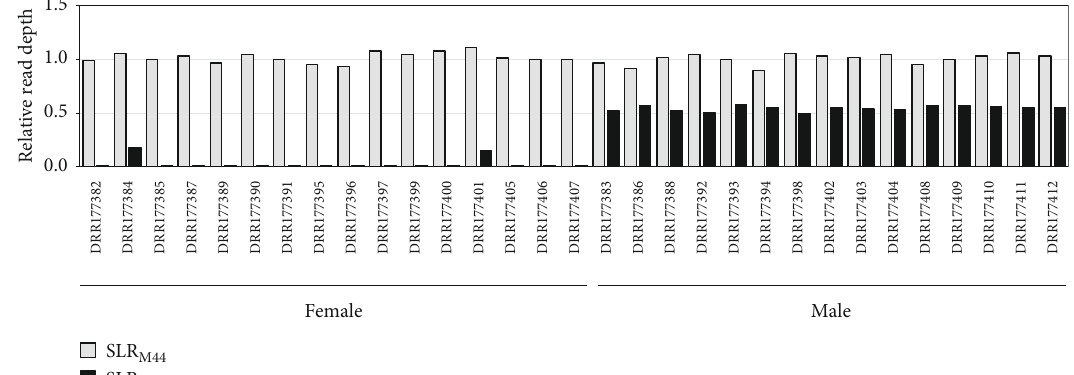
Figure 4: Comparison of relative read depths between males and females for SLR by the accession number (DRR number).